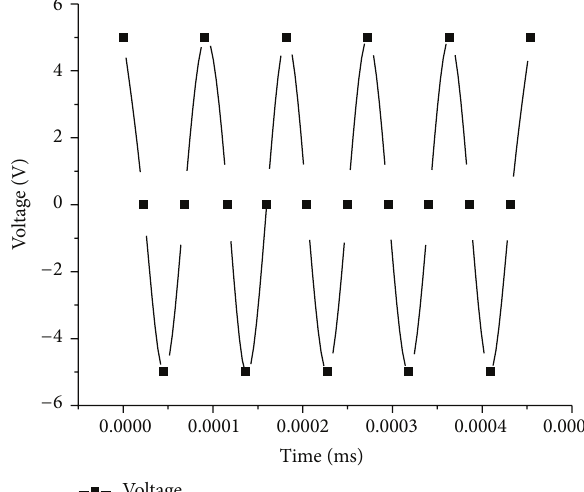
Figure 4: Input cosine waveform applied to longer cantilever